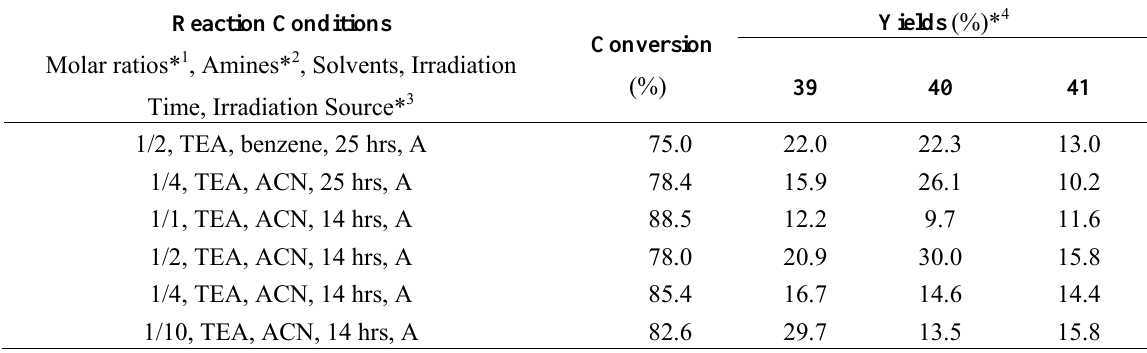
Table 5. Yields and conditions of photoinduced biflavanone formation with amines. Reaction